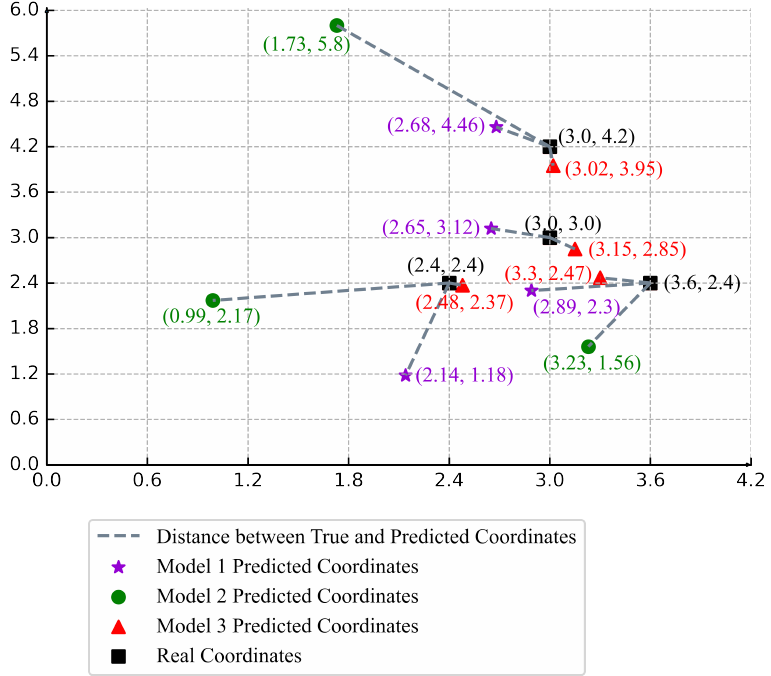
Figure 5. Comparison of model predictions and real coordinates.